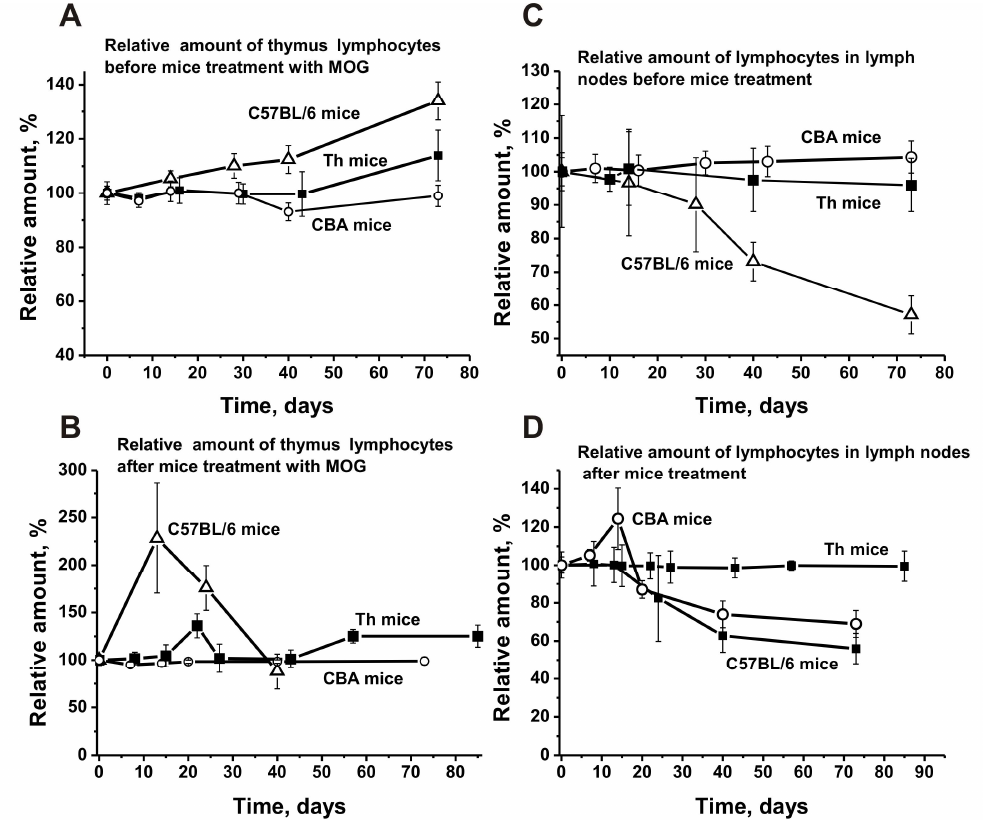
Figure 6. The average changes over time in the relative number of lymphocytes before and after treatment with MOG in the thymus ( A,B ) and lymph nodes ( C,D ) of C57BL / 6, CBA, and Th mice. First, the relative number of lymphocytes was estimated from optical density for each mouse and all groups (with seven mice per group); the error from three independent experiments did not exceed 7–10%. Then the relative number of lymphocytes (optical density) before immunization at time zero of the experiment was taken as 100%.